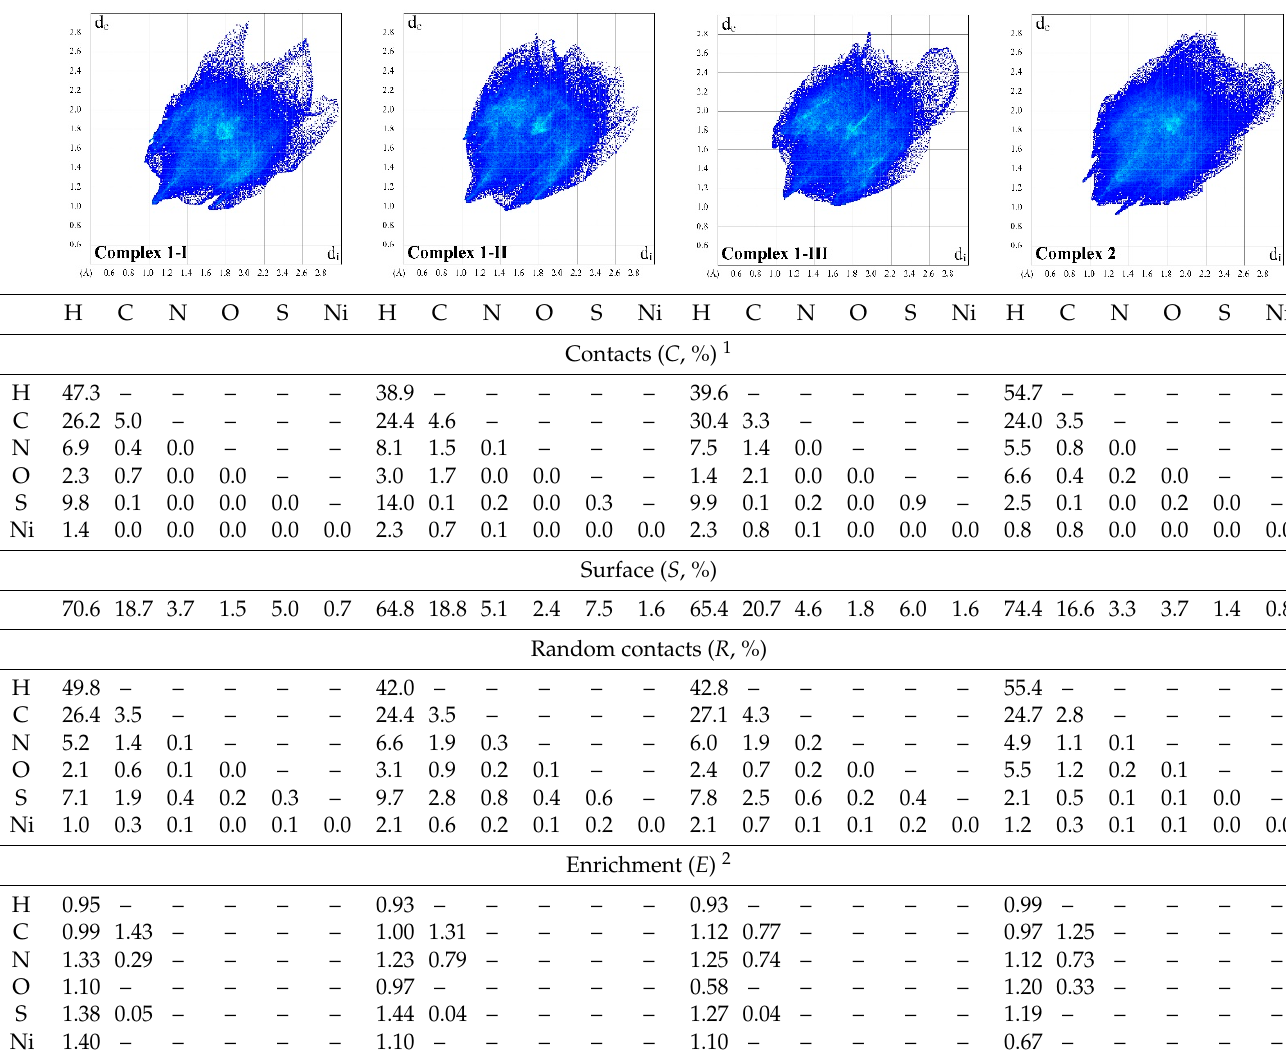
Table 5. Hirshfeld Contact Surfaces and Derived “Random Contacts” and “Enrichment Ratios” for 1-I , 1-II , 1-III , and 2 .